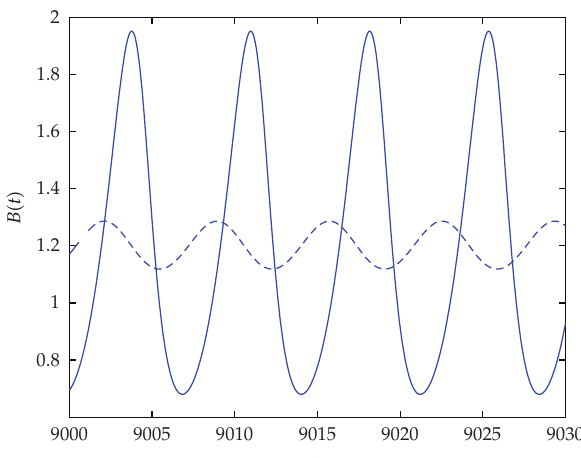
Figure 4: The unstable (cid:5) dashed line (cid:6) and stable (cid:5) solid line (cid:6) limit cycles for the solution B (cid:5) t (cid:6) at the same value of β (cid:7) 0 .